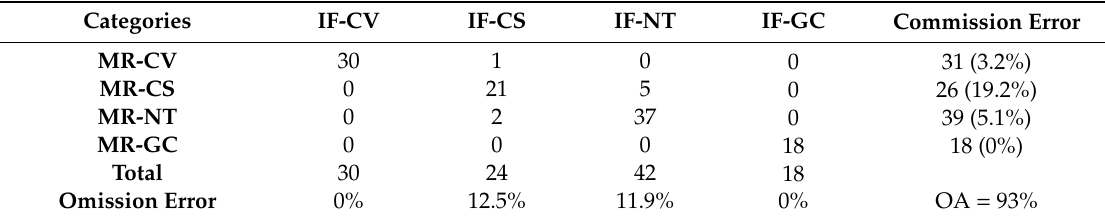
Table 1. Error matrix mobile roadside (MR) oblique vs. ground collected nadir in-field (IF) imagery, for conventional tillage (CV); conservation tillage (CS); no-till (NT); and green cover (GC) practices. Validation was carried out over 114 field sites in Elgin and Essex County. Omission and Commission error values for each land class are reported in the last row and column, respectively, with an overall accuracy (OA) of 93%.